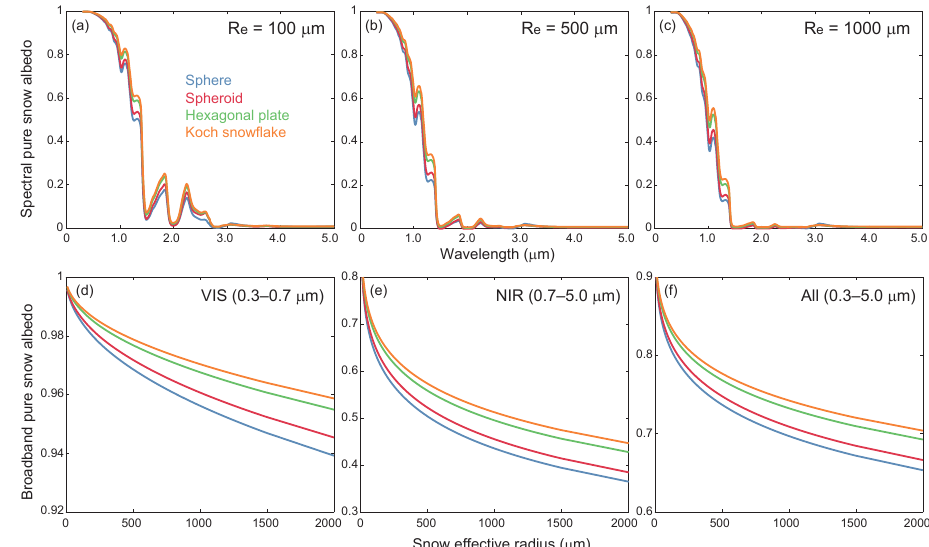
Figure 3. (a–c) Spectral (0.3–5µm) direct-beam albedo of pure semi-infinite snow layers with effective radii ( R e ) of (a) 100, (b) 500, and (c) 1000µm for sphere (blue), spheroid (red), hexagonal plate (green), and Koch snowflake (orange) based on the updated SNICAR model. (d–f) Same as (a–c) , but for broadband albedo as a function of snow effective radius ( R e ) at (d) visible (VIS, 0.3–0.7µm), (e) near-infrared (NIR, 0.7–5µm), and (f) all (0.3–5µm) wavelengths. The results for diffuse snow albedo are shown in Fig. S1 in the